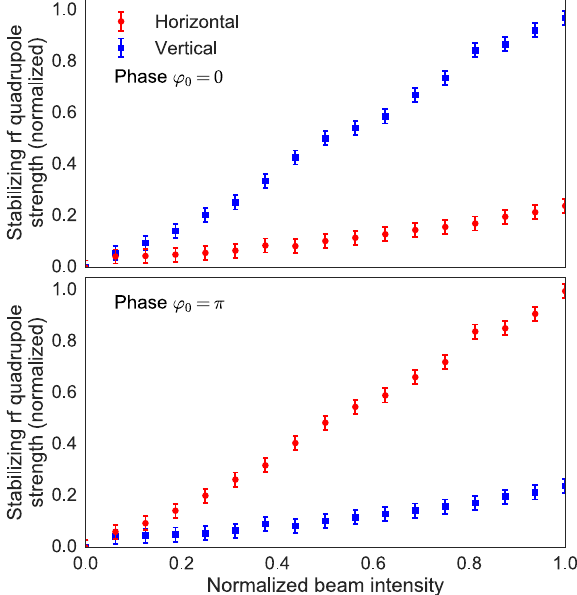
FIG. 13. P y HEADTAIL tracking simulations illustrating the stabilizing efficiency in the horizontal (red) and the vertical (blue) planes with an rf quadrupole with φ 0 ¼ 0 (top) and φ 0 ¼ π (bottom) respectively.